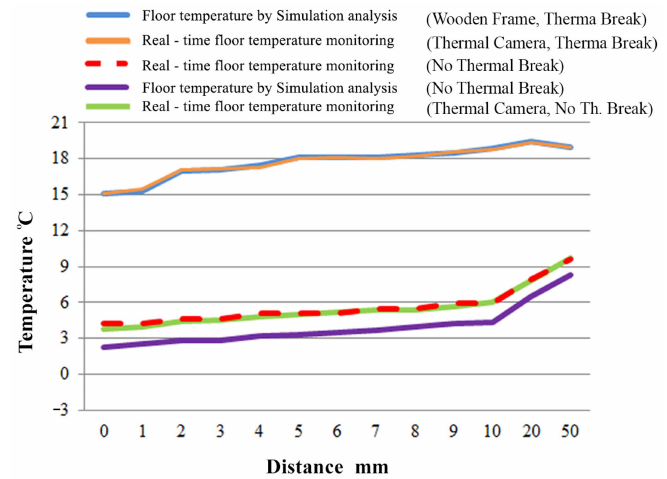
Figure 8. Validation of data before and after the implementation of the insulating